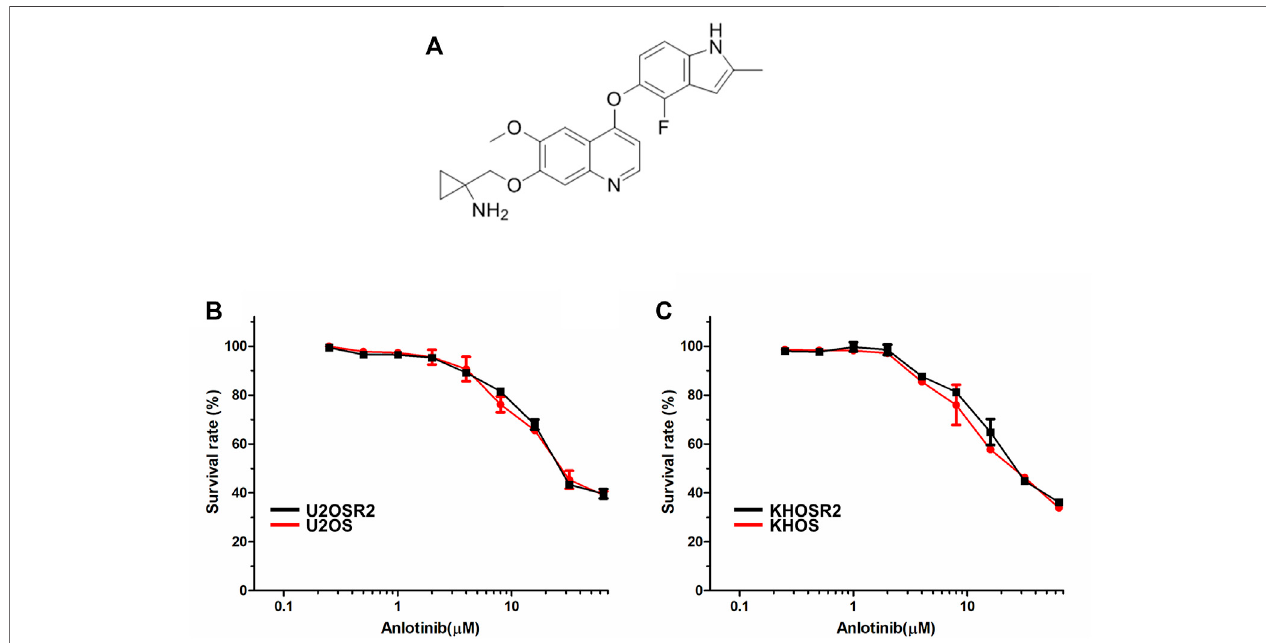
FIGURE 1 | The structure of anlotinib and the cytotoxicity of anlotinib in drug-resistant osteosarcoma cell lines and their drug-sensitive parental cell lines. (A) . The structureofanlotinib.Osteosarcomadrug-resistantandtheirdrug-sensitivecelllinesweretreatedwithanlotinibattheindicatedconcentrationsfor48 h.Cellviabilitywas measuredby CCK8 (B) . Cytotoxicity curvesfor theU2OSR2 and U2OS cell lines incubated with anlotinib alone. (C) .Cytotoxicity curves forthe KHOSR2 and KHOS cell lines incubated with anlotinib alone. The data were shown as the mean ± SD from three independent experiments.